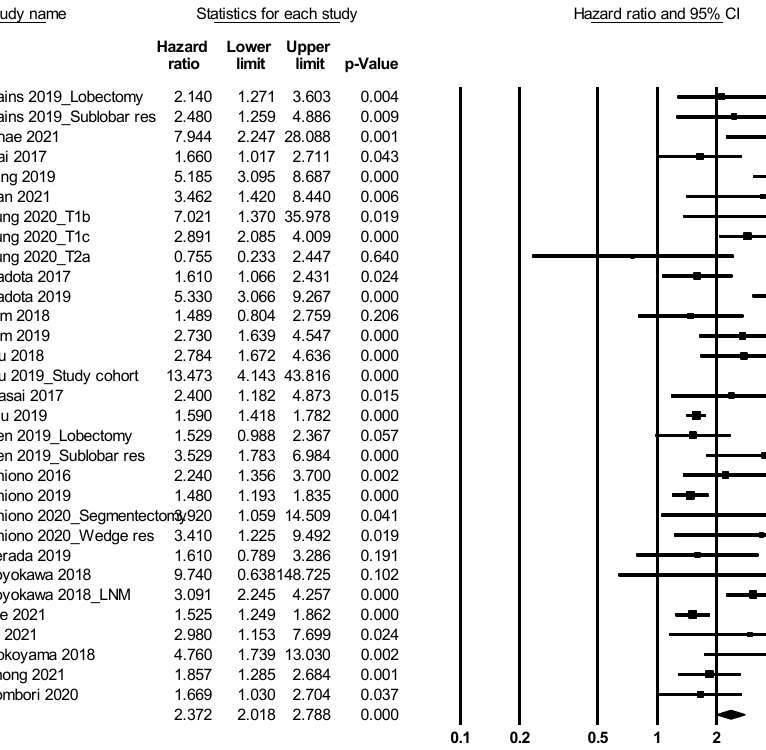
Table 5. Comparisons of prognosis between lung cancers with STAS and non-STAS.